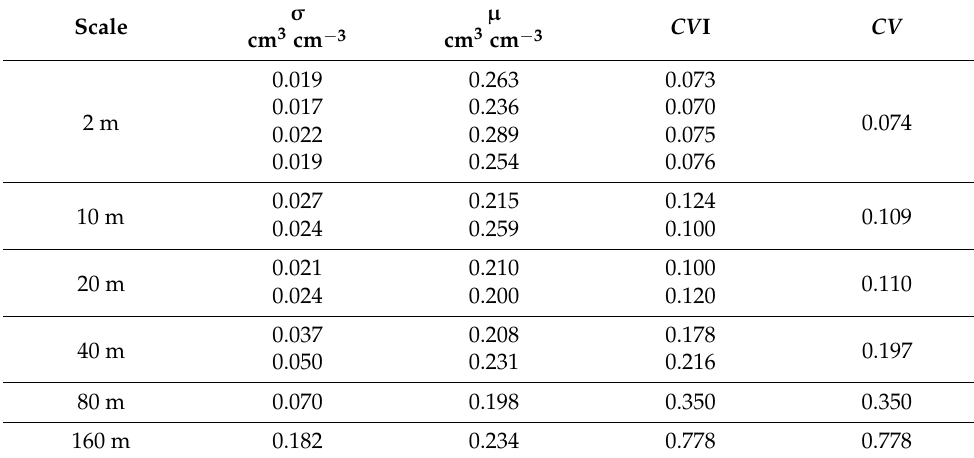
Table 2. Surface soil moisture statistics at different scales.